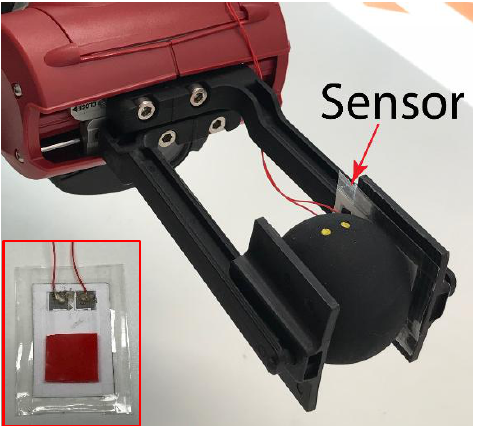
Figure 10. Sensor integrated into a robot gripper, ( inset ) fabricated sensor with optional fourth layer for better grip.